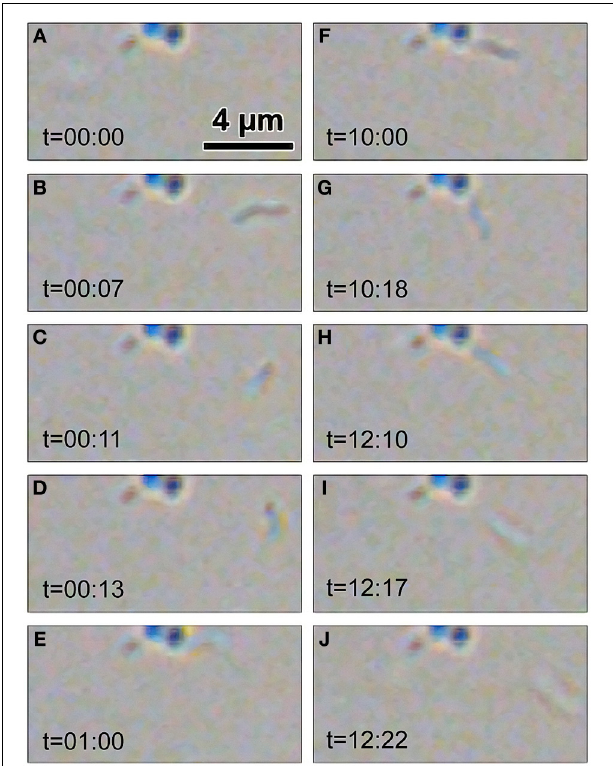
FIGURE 2 | B. bacteriovorus predation on two S. aureus prey cells. Frames (A–J) from Supplementary Video S1 (bright field, 100X magnification) depicting predation phases of B. bacteriovorus on two S. aureus cells. Time (t) is expressed as “seconds:frames,” where each second is made of 25 frames. A single B. bacteriovorus enters from the left, attacks its prey (right, dark blue) and after around 12s moves away. A